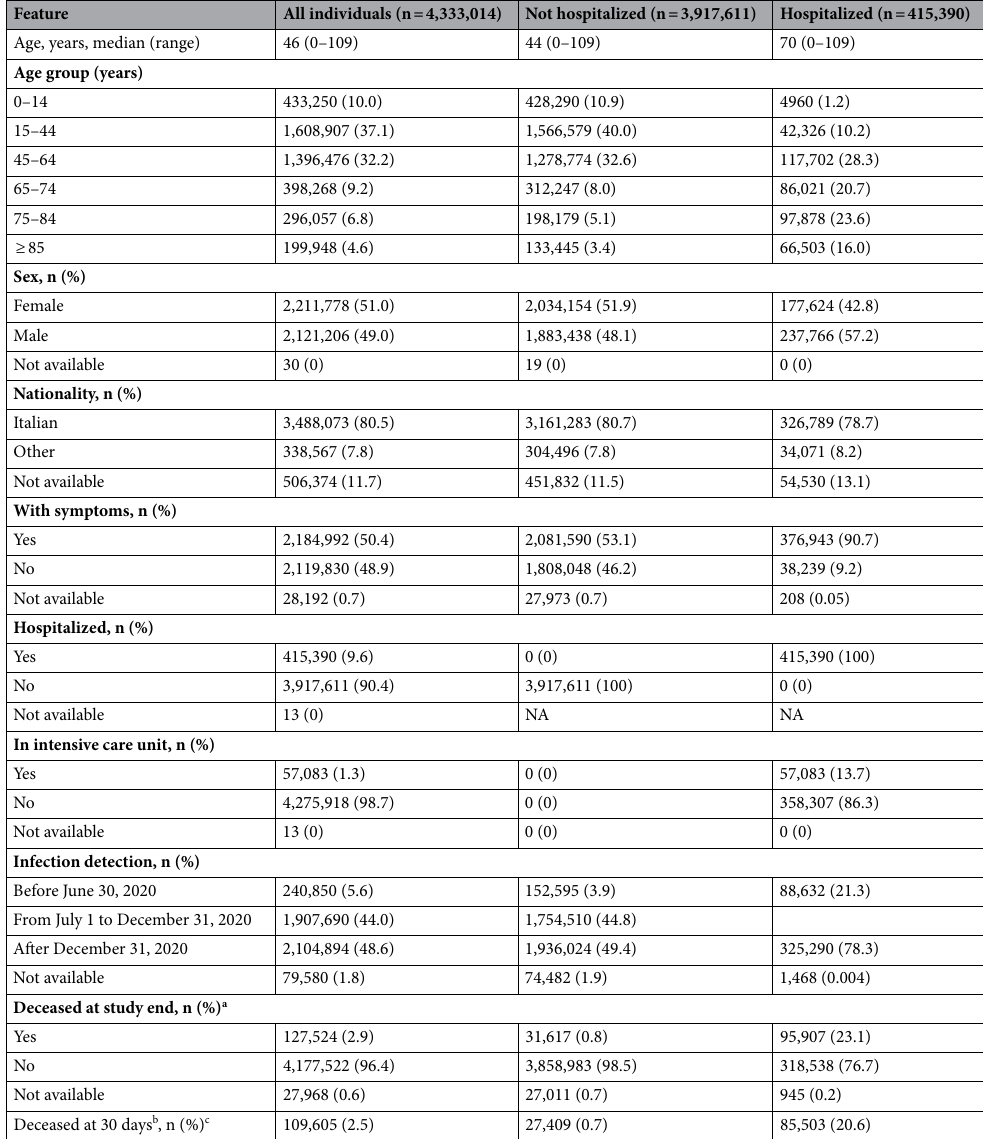
Table 1. Demographic and clinical features of 4,333,014 SARS-CoV-2-positive individuals in the Italian national database, from January 28, 2020 to July 25, 2021. NA not applicable. a July 25, 2021. b And with data available for survival analysis. c For the entire cohort and for non-hospitalized persons, 30 days after infection detection (positive PCR test). For hospitalized persons, 30 days after